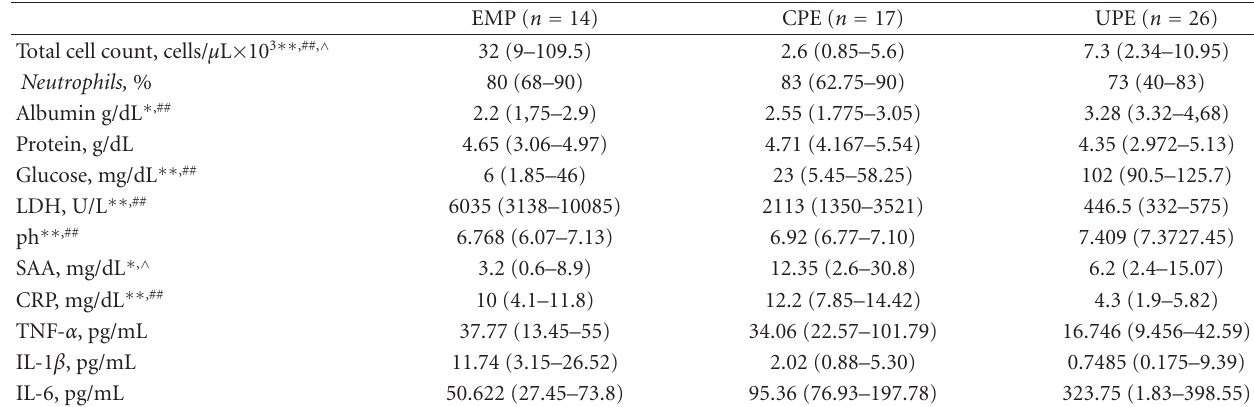
Table 2: Pleural fluid characteristics in di ff erent PPE types.